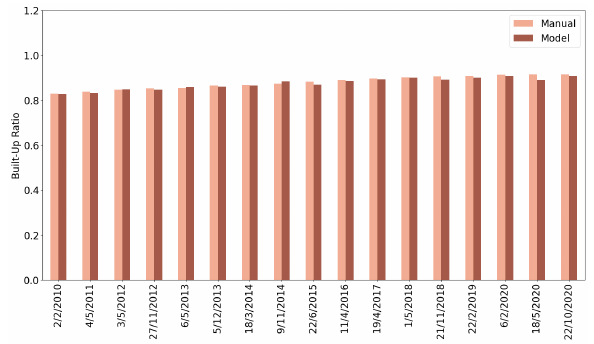
Figure 7. Temporal Consistency of the model: The results for temporal consistency performance of our model. On x-axis, we have images on different dates (dd/mm/yyyy format) for same regions (Phase 1) of DHA and on y-axis we show the estimated and ground truth BRs for that